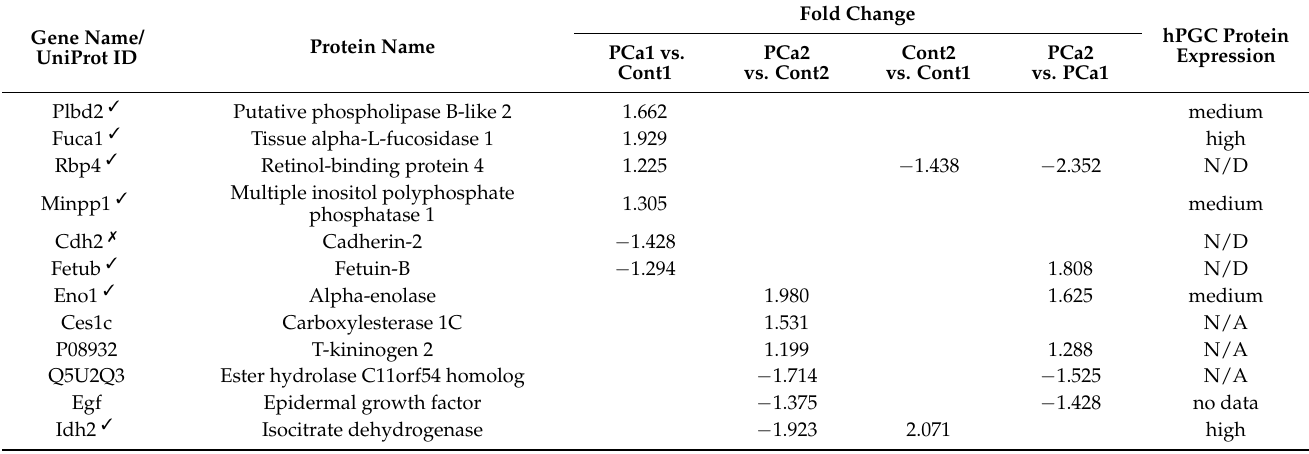
Table 3. List of proteins obtained by GeLC-MS/MS with differential abundance ( p < 0.05) in urine between groups (five animals per group). Negative or positive fold change values represent the down-regulation or up-regulation, respectively, of the protein. Information about their presence on human prostate glandular cells (hPGC) and detection on human prostate cancer (tissue sections), according to Human Protein Atlas, is also demonstrated. Legend: (cid:51) : detected in human prostate cancer (tissue sections); (cid:55) : not detected in human prostate cancer (tissue sections); N/D: not detected in hPGC; N/A: not applicable (protein only present in